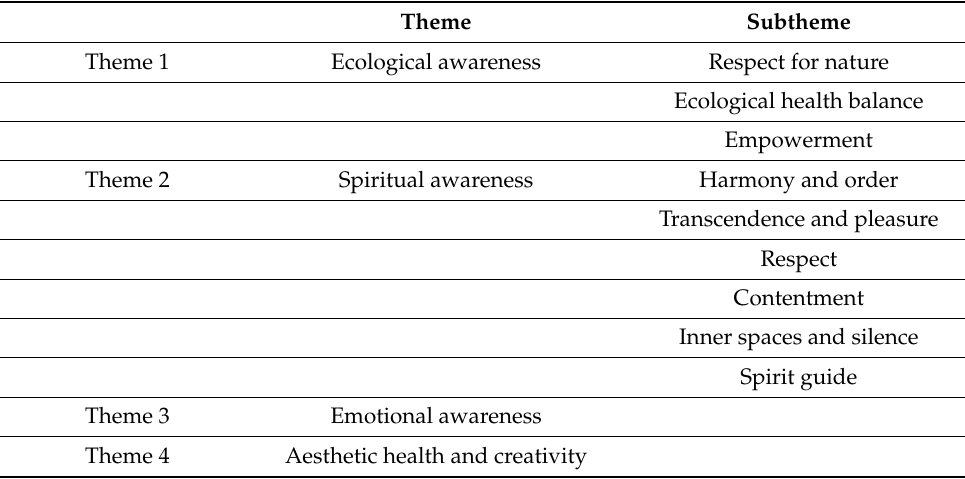
Table 3. Summary of major themes found in narratives of